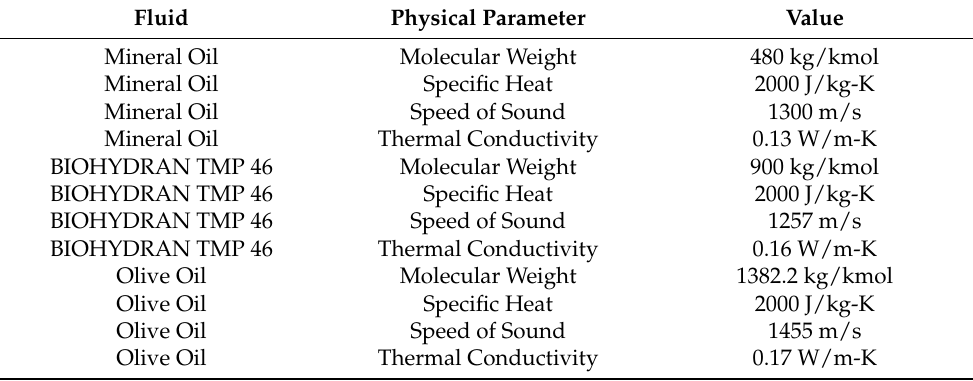
Figure 9. Eco-friendly fluids properties: ( a ) BIOHYDRAN TMP 46: density vs. temperature; ( b ) BIOHYDRAN TMP 46: viscosity vs. temperature; ( c ) olive oil: density vs. temperature; ( d ) olive oil: viscosity vs. temperature. Table 4. Molecular weight, specific heat, speed of sound, and thermal conductivity of the three fluids.